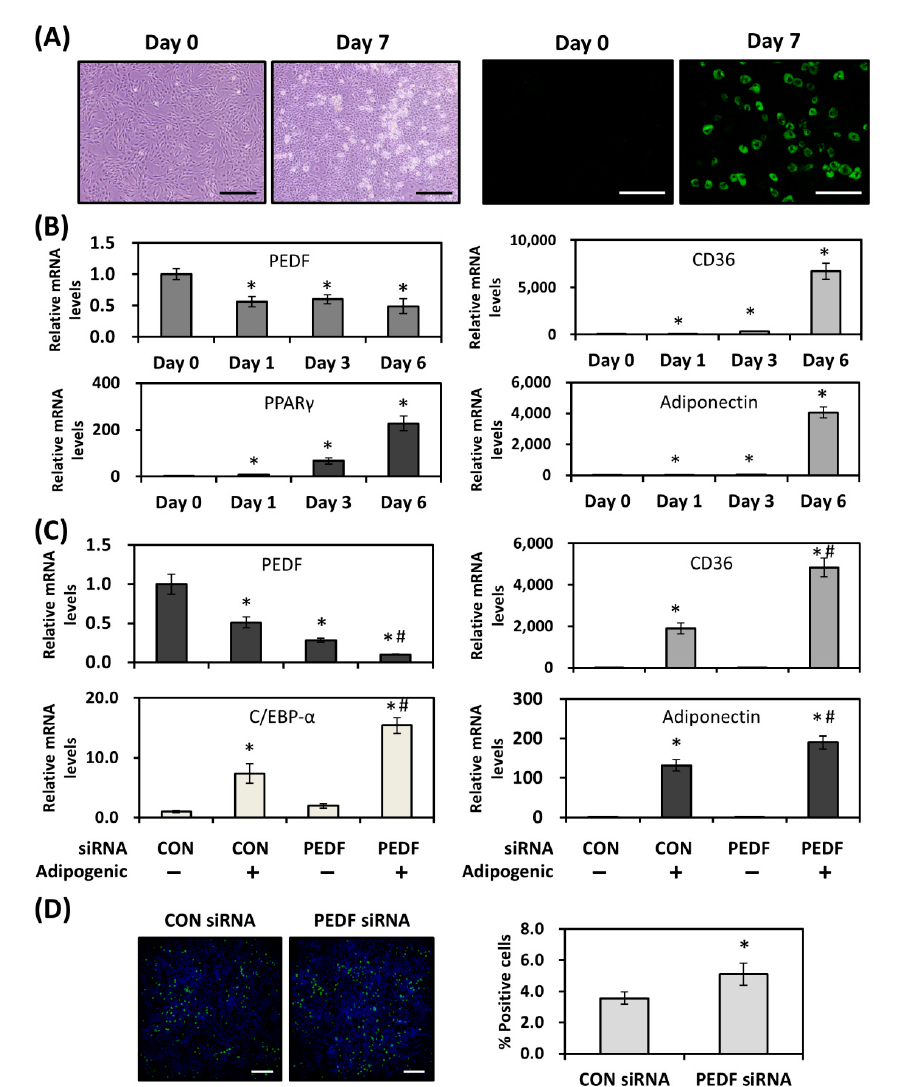
Figure 1. Decreased PEDF is associated with CD36 up-regulation and increased differentiated adipocyte number during the adipogenic differentiation of adipose-derived stem cells (AdSCs). ( A ) Differentiated rat AdSCs were fixed and stained with BODIPY 493/503. Representative brightfield and fluorescence micrographs of undifferentiated and differentiated AdSCs are shown. Scale bar: 100 µ m (left), 50 µ m (right). ( B ) Gene expression of PEDF, CD36, PPAR γ , and adiponectin in differentiating AdSCs was measured using quantitative RT-PCR. ( C ) Gene expression was evaluated in differentiated AdSCs that were transfected with control or PEDF small interfering RNA (siRNA) using quantitative RT-PCR. ( D ) As in ( C ), differentiated rat AdSCs were stained with BODIPY 493/503 and counterstained with DAPI. Percent positive cells were determined by calculating the percentage of positively stained cells in all DAPI-stained cells. Scale bar: 500 µ m. * Statistically significant compared with the control transfected, vehicle-treated group at p < 0.05; # statistically significant compared with the PEDF siRNA-transfected, vehicle-treated group at p < 0.05. To functionally demonstrate the effect of PEDF knockdown on adipogenesis, rat AdSCs transfected with control or PEDF siRNAs were assessed six days after the induction of adipogenic